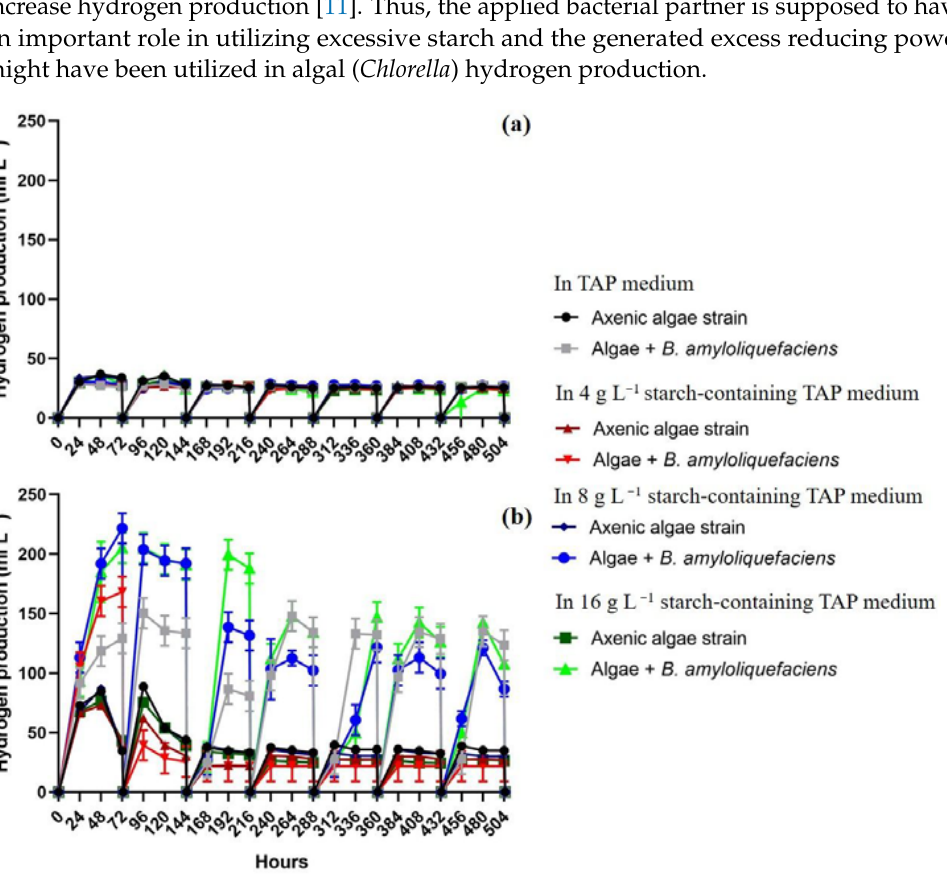
Figure 1. Hydrogen production of C. reinhardtii cc124 ( a ) and of Chlorella sp. MACC-360 ( b ) in fed-batch experiments in TAP media (the initial bacterial OD 600 of 0.07). Hydrogen was measured every 24 h in the headspace and 5 min aerated after each measurement every 72 h. Error bars are standard deviations based on three replicates.